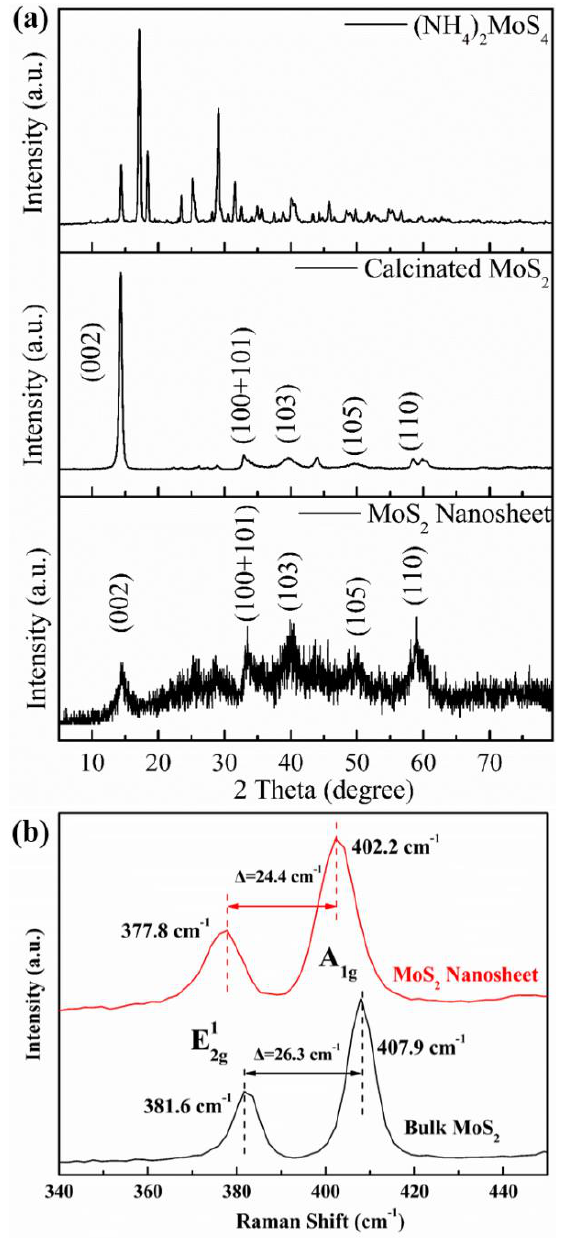
Figure 1. ( a ) XRD patterns of (NH 4 ) 2 MoS 2 , bulk MoS 2 , and MoS 2 -NS and ( b ) Raman spectra of bulk MoS 2 and MoS 2 nanosheets.